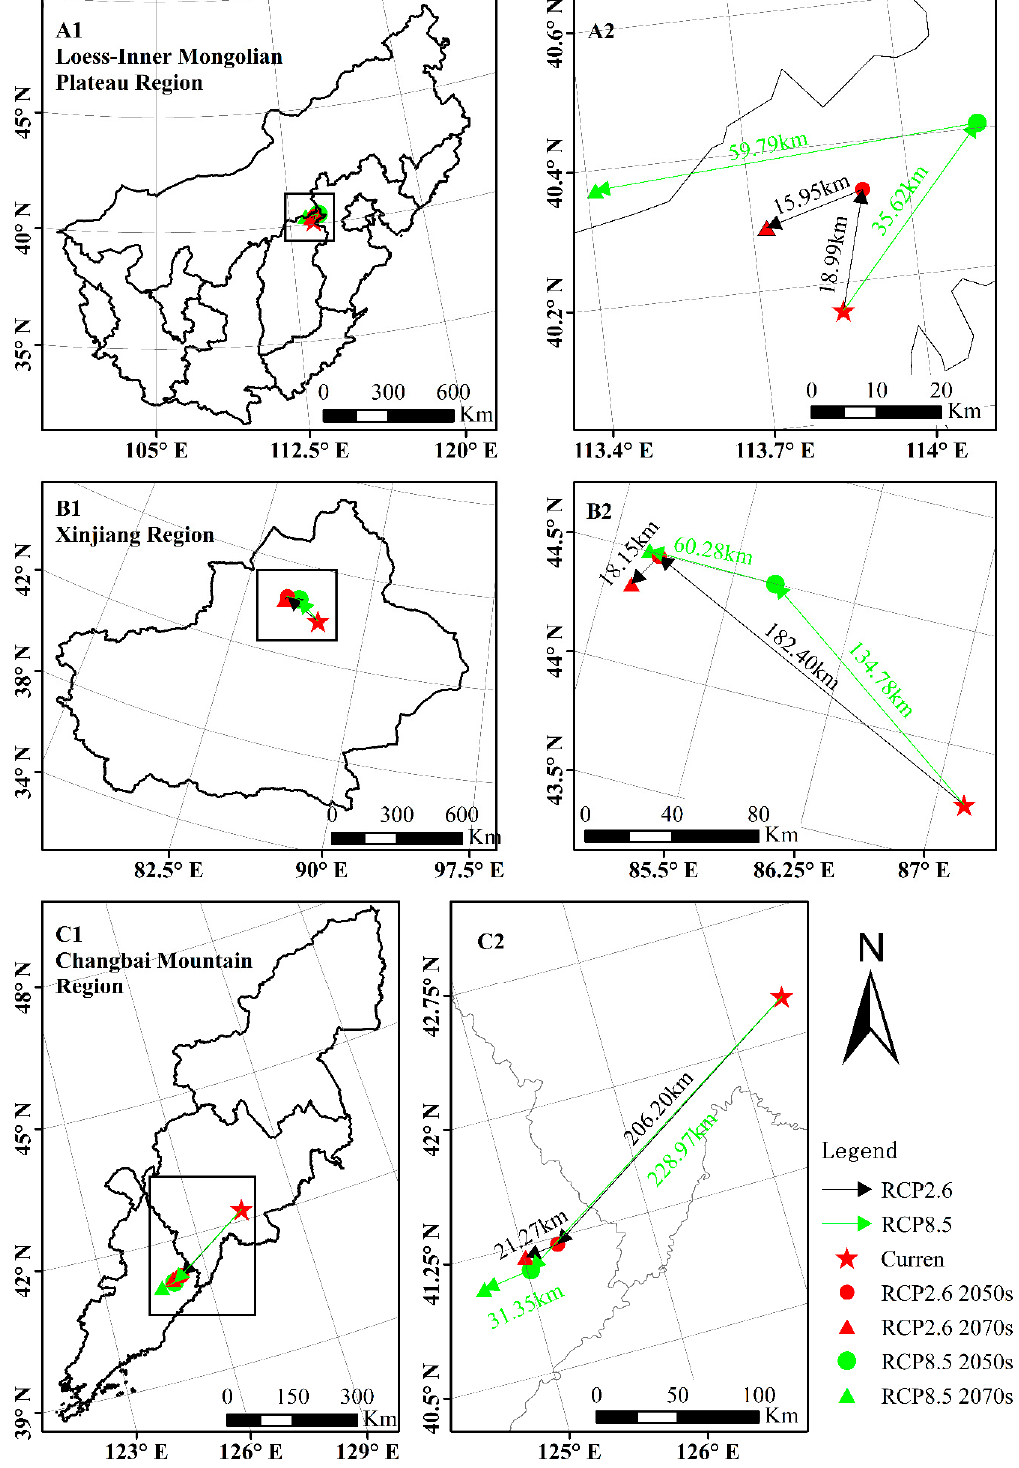
Figure 4. The core distributional shift under future climate scenarios for Juniperus rigida Sieb. et Zucc. in three main distribution areas. ( A1 ) illustrated the shift path in the Loess-Inner Mongolian region—full figure, ( A2 ) illustrated the shift path in the Loess-Inner Mongolian region—detail figure, ( B1 ) for the Xinjiang region—full figure, ( B2 ) for the Xinjiang region—detail figure, ( C1 ) for the Changbai Mountain region—full figure, ( C2 ) for the Changbai Mountain region—detail